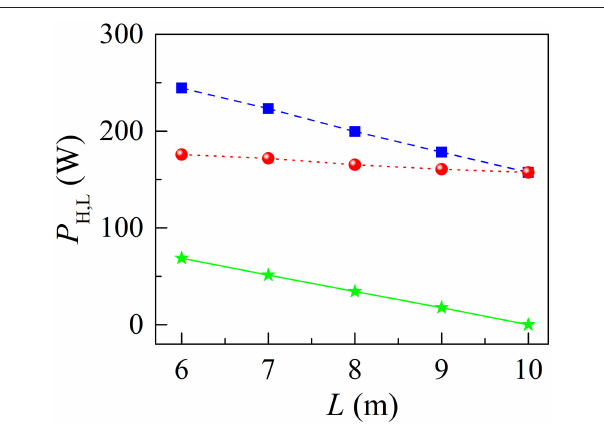
FIGURE 5 | The P H and P L values vs. ρ . Their difference as a function of ρ is shown by the solid green curve.